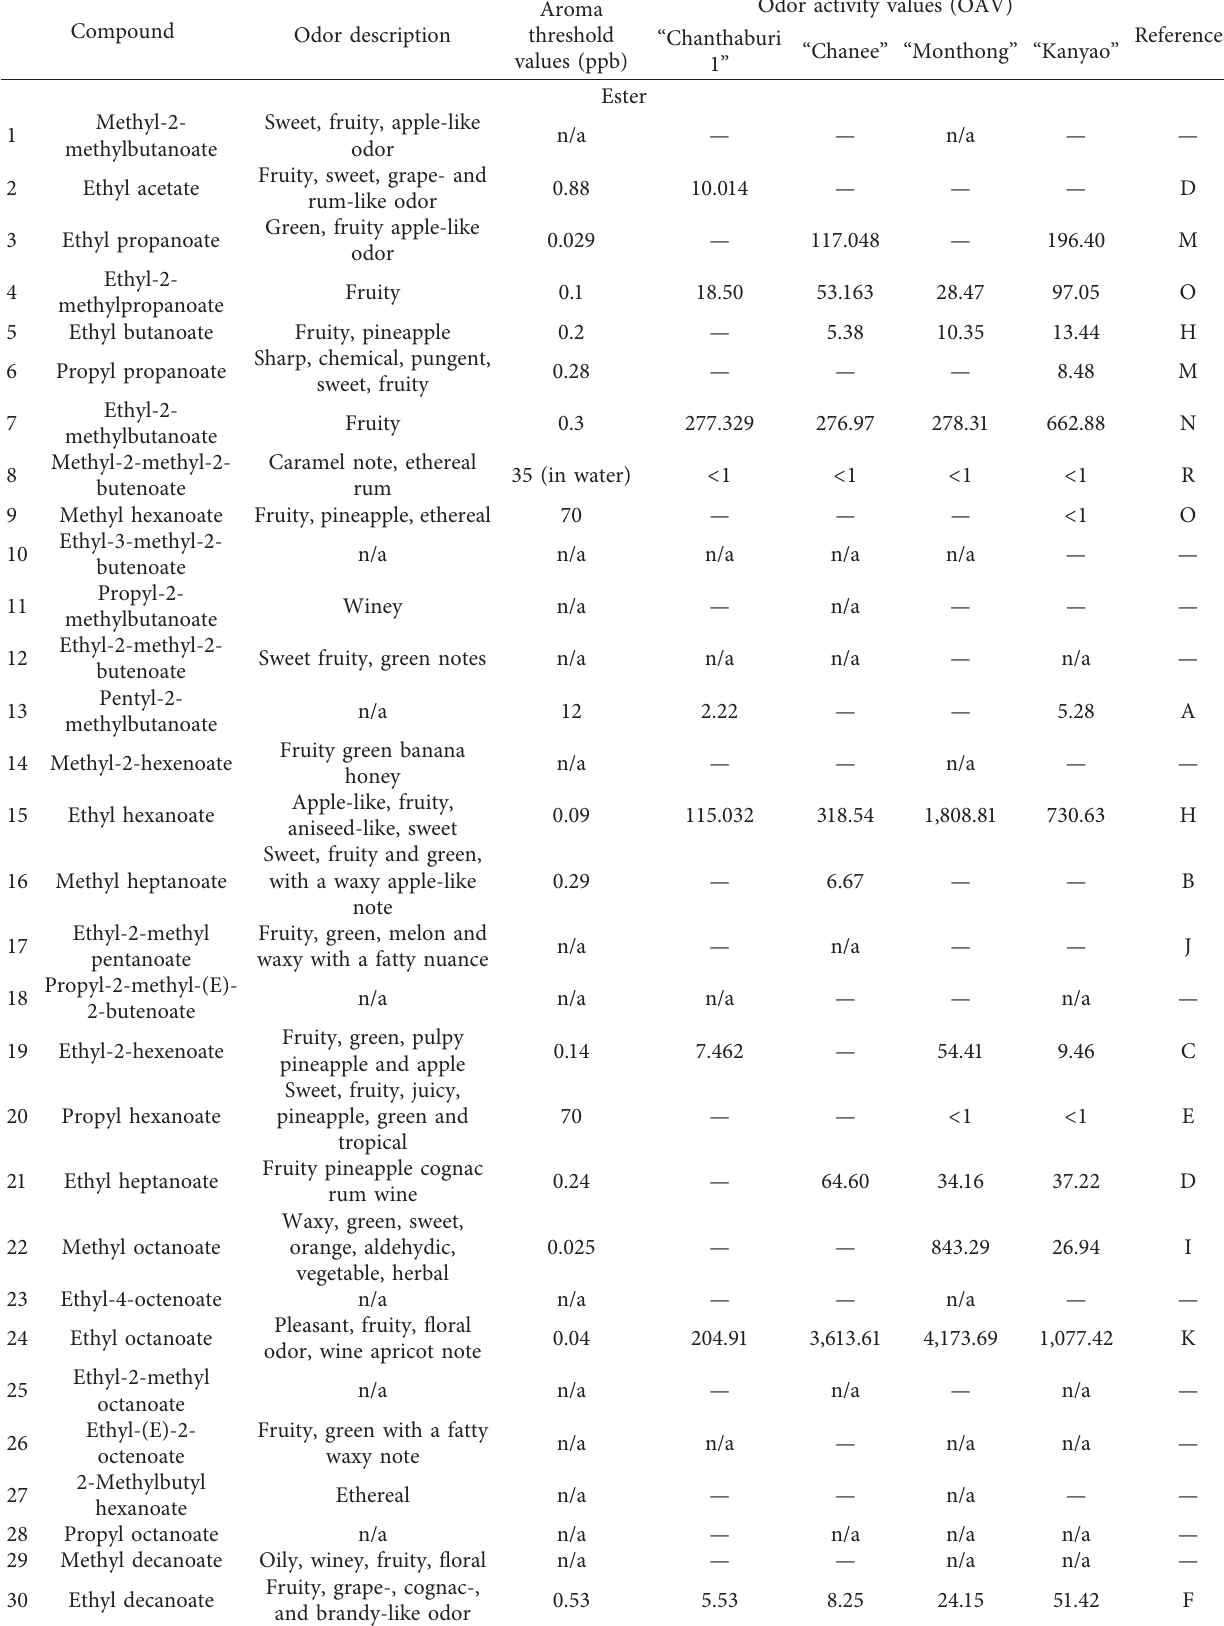
Table 2: Odor characteristics of ester, sulfur, acid, phenolic, and aldehyde containing compounds from ripe flesh of 4 Thai durian fruits.